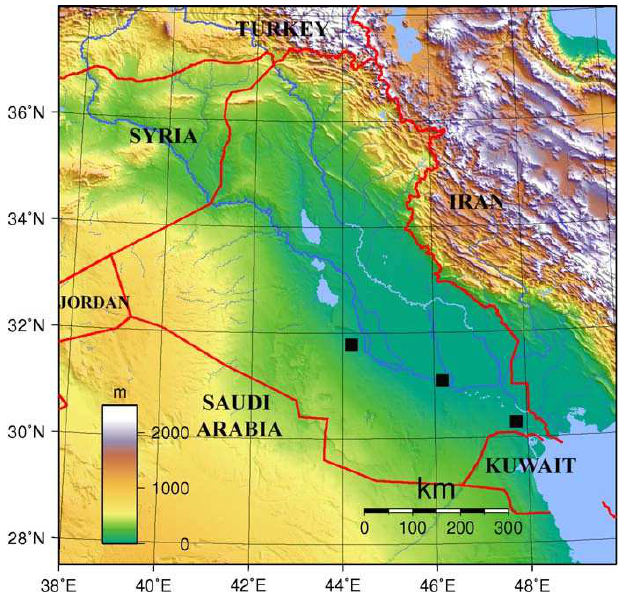
F IGURE 1. Map showing the coordinates of sampling sites (black squares) for Trapelus r. ruderatus in southern